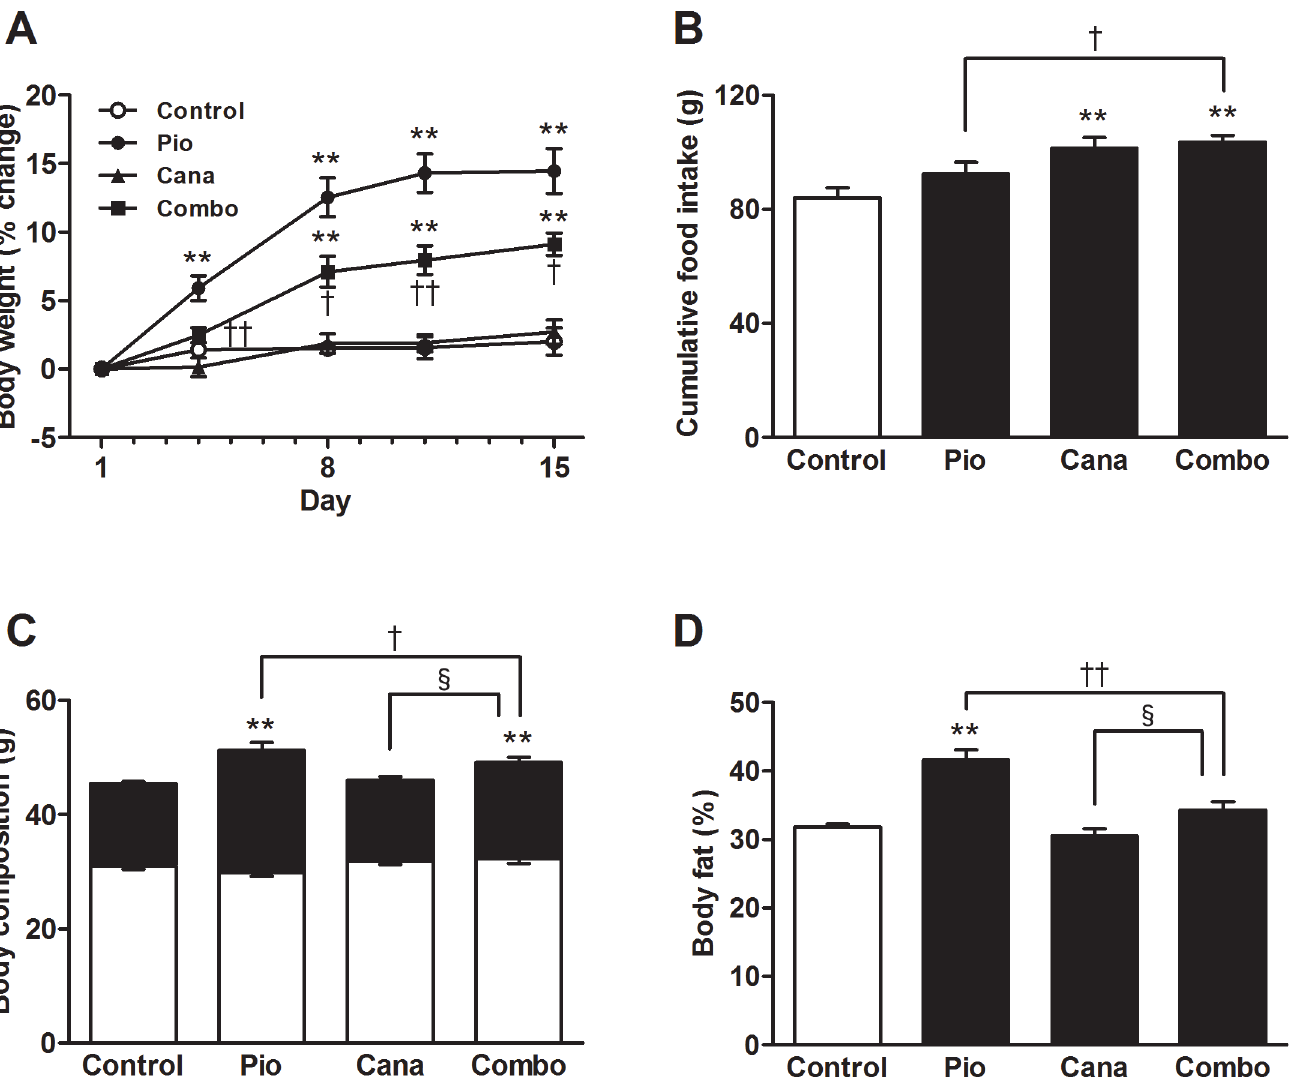
Figure 2. Body weight, food intake, and body composition by dual-energy X-ray absorptiometry (DEXA) in KK-A y mice. A: Body weight percent change, B: Cumulative food intake, C: Body composition (lean mass, open column; fat mass, closed column), and D: Body fat. Canagliflozin (Cana; 0.01% w/ w food admixture), pioglitazone (Pio; 0.01% w/w food admixture), and their combination (Combo) were administered for 2 weeks. Body composition and body fat were measured at the end of the study using the DEXA scanner. Data are expressed as mean ± SEM (n = 7). ** P < 0.01 vs. control, † P < 0.05, †† P < 0.01 vs. Pio, § P < 0.05 vs.